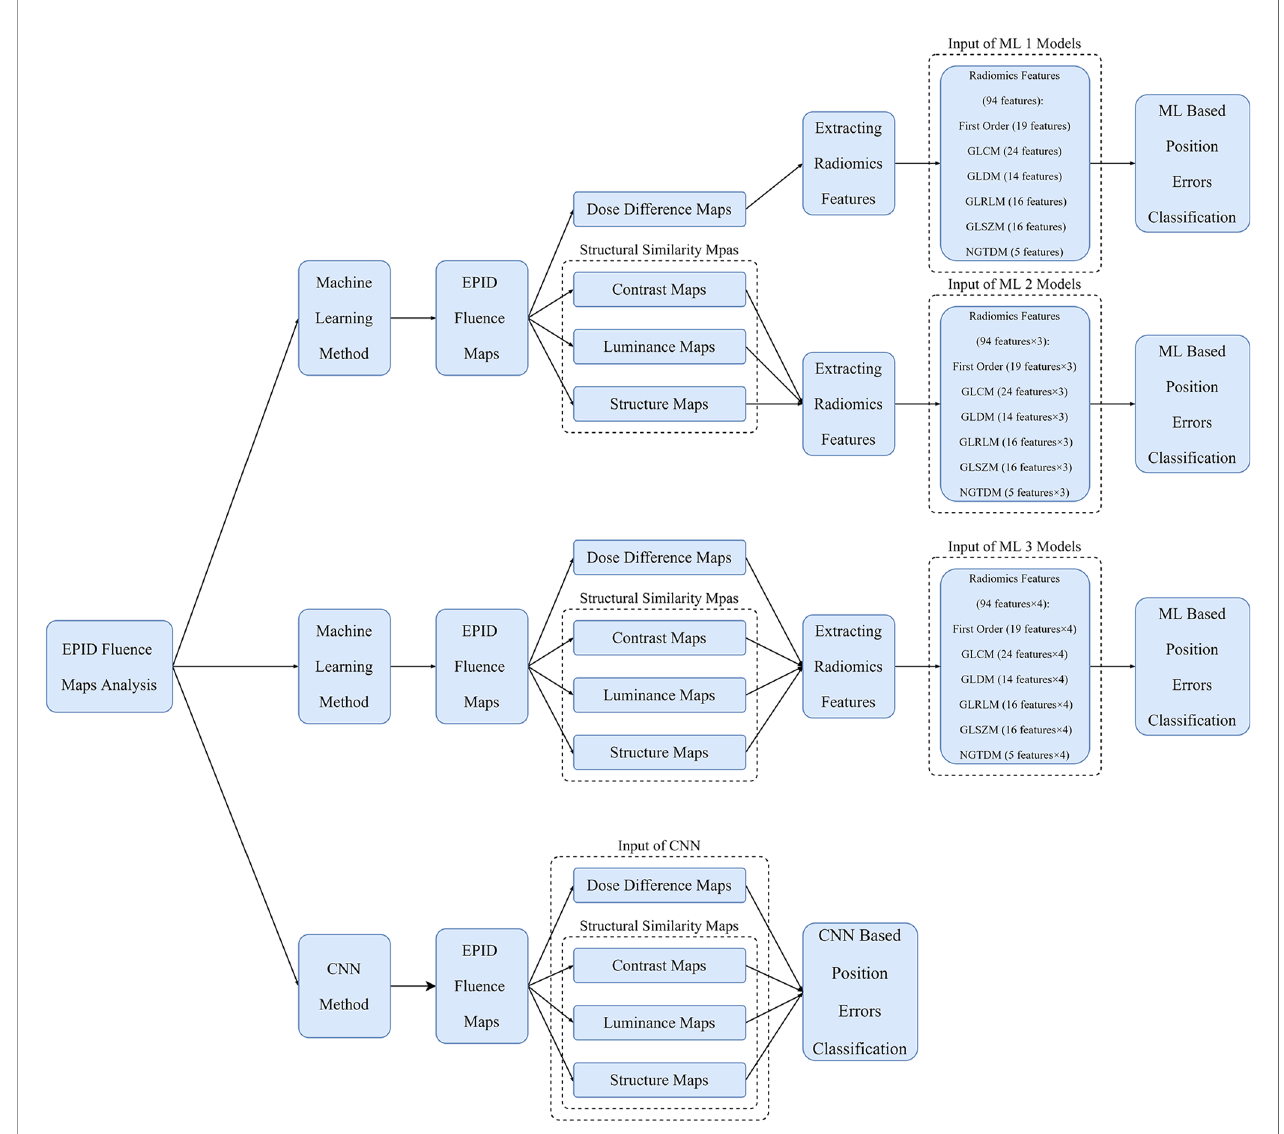
FIGURE 4 | Overview of work fl ow of ML models and CNN for position error classi fi cation. The inputs of the ML 1 model are features of DD maps; those of the ML 2 model are features of SSIM maps; those of the ML 3 model are features of DD and SSIM maps; and those of the CNN are DD and SSIM